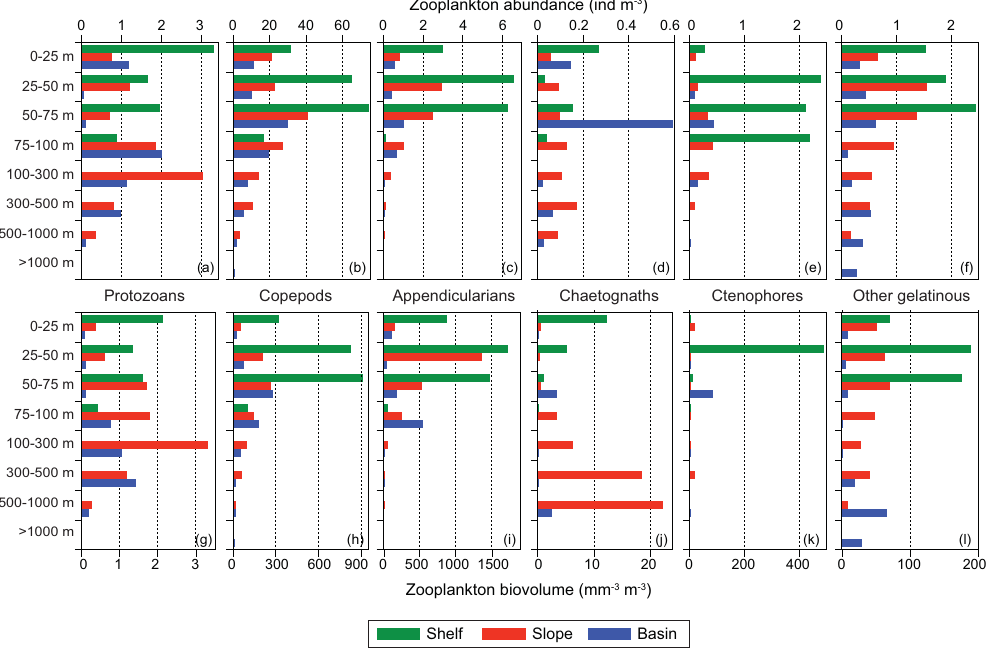
Fig. 5. Vertical distribution of zooplankton group abundance (a–f) and biovolume (g–l) as identified and measured with the Underwater Vision Profiler across the shelf ( < 100m), slope (100–1000m) and basin ( > 1000m) areas of southeast Beaufort Sea in July–August 2009. The zooplankton abundance and biovolume averaged for the entire water column within each of the defined regions are presented in Table 3.